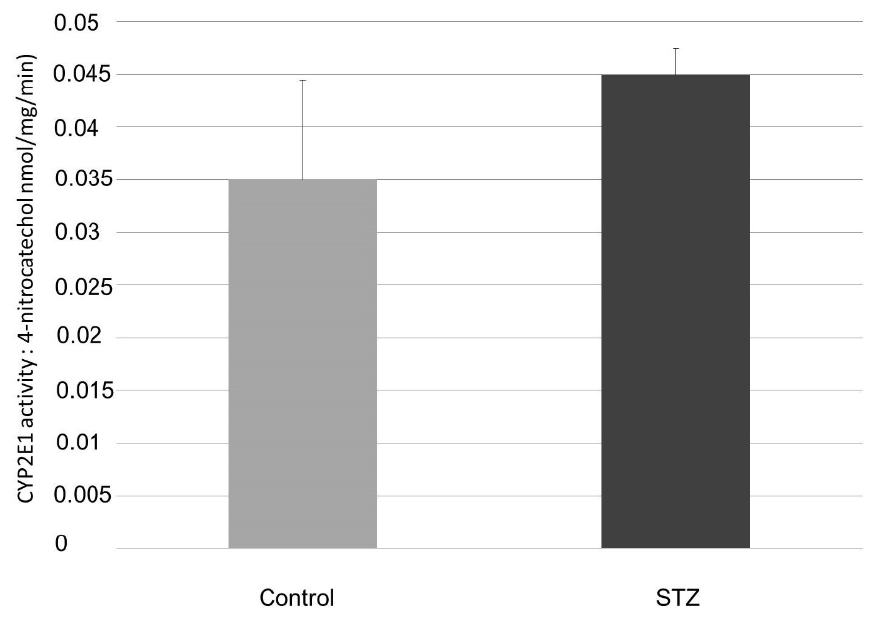
Figure 7. Activity of CYP 2E1 of the small intestine in control and diabetic rats. Values represent the mean ± S.E. of five rats. Each value represents the mean of 5 independent experiments ± standard error. The enzyme activity is expressed in nmol 4 ‐ nitrocatechol/mg/min.